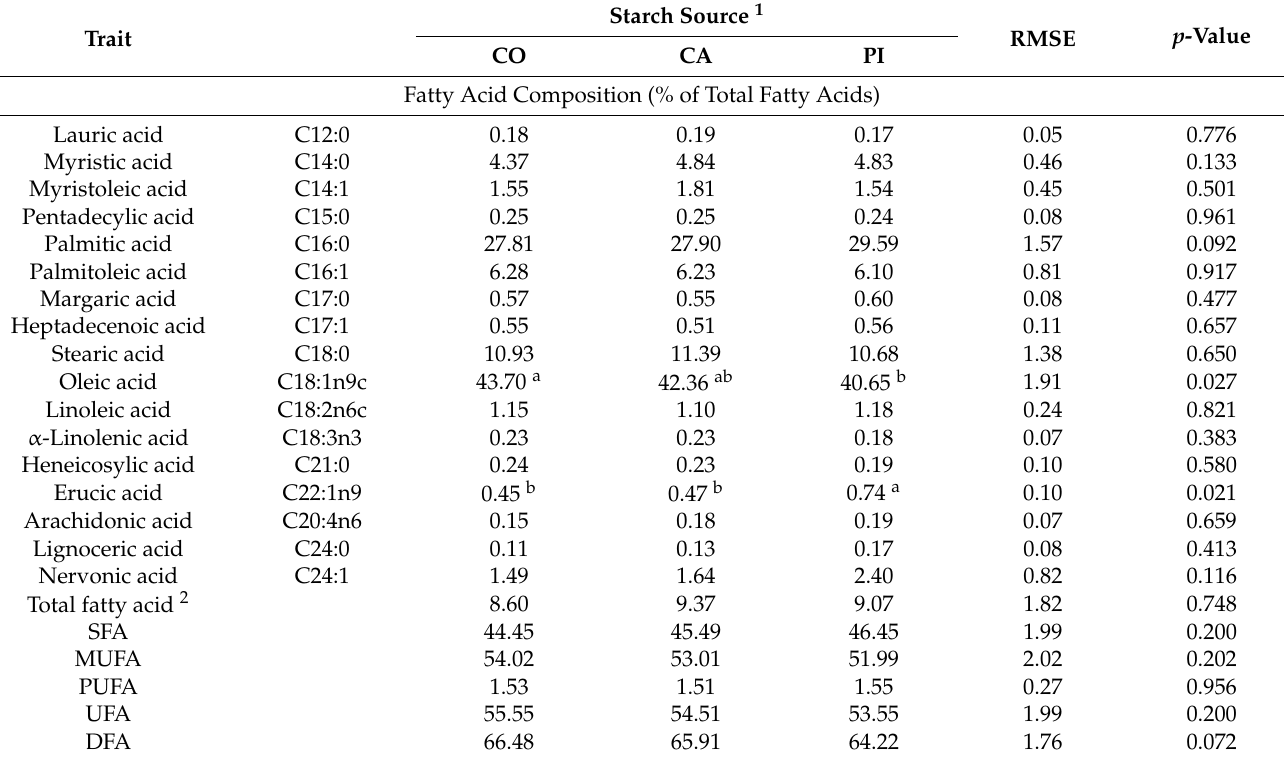
Table 3. Effect of starch source of concentrate on fatty acid composition of fattening dairy